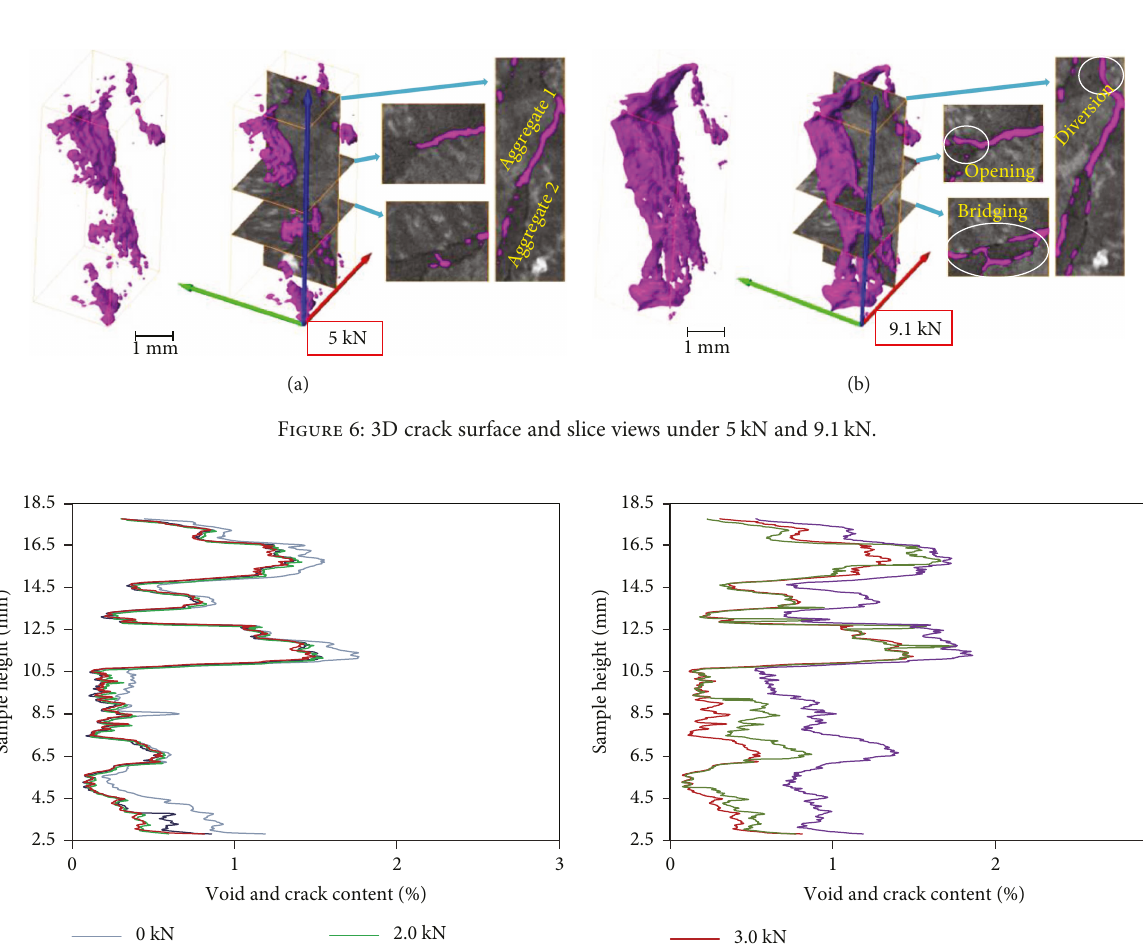
Figure 5: Localised cracking in a subvolume ( XY slice).